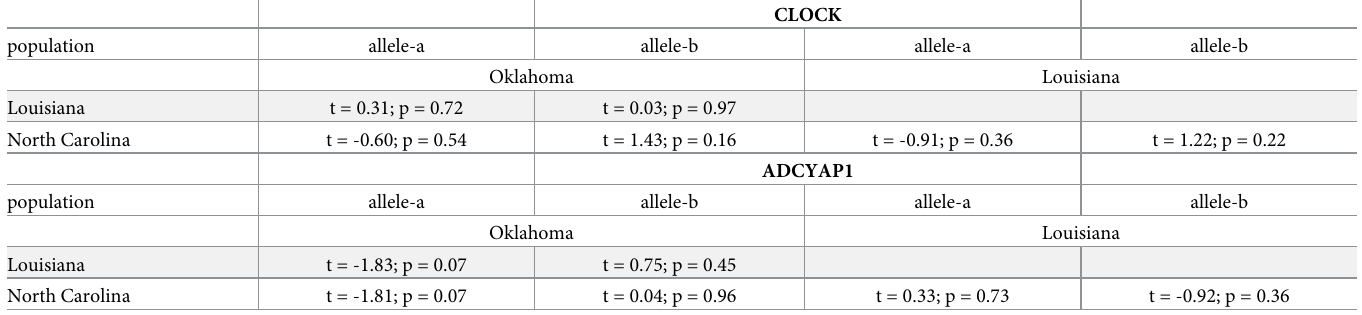
Table 4. Differences in microsatellite allele size between populations at Clock and Adcyap1 . No significant microsatellite allele size differences were found between Oklahoma, Louisiana, and North Carolina populations (p > 0.05). Allele-a indicates short alleles and allele-b indicates long